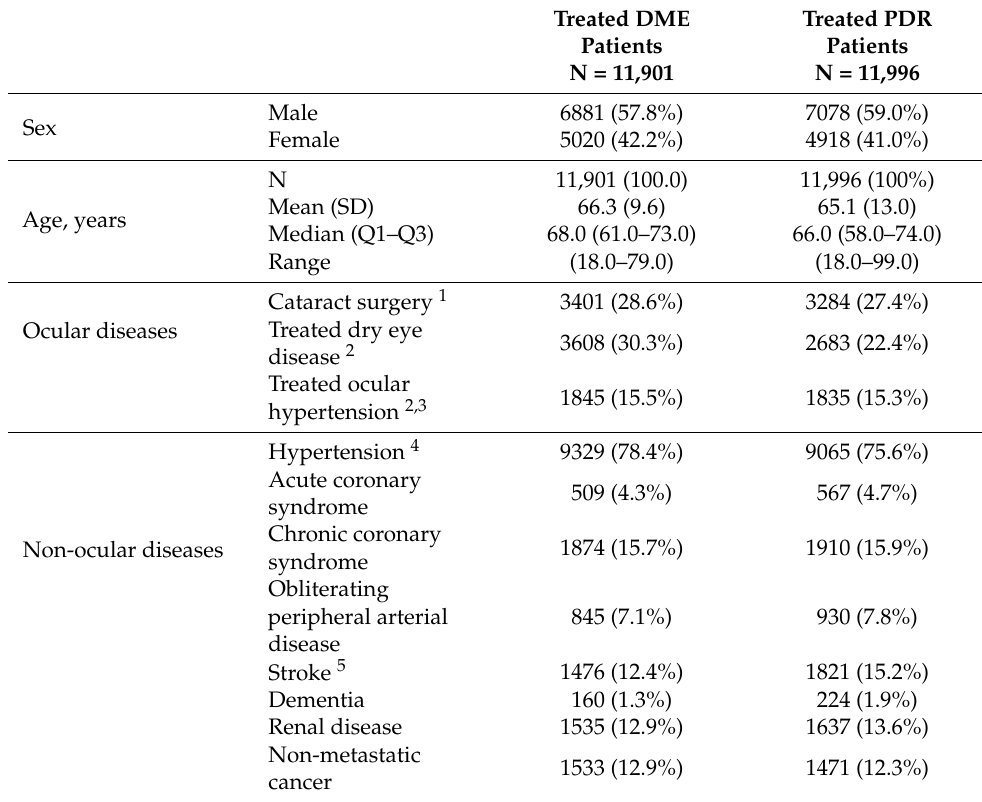
Table 1. Demographics and characteristics of incident treated DME and PDR patients in